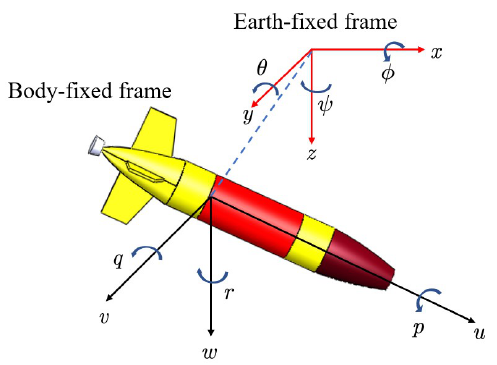
Figure 1. Schematic diagram of coordinate